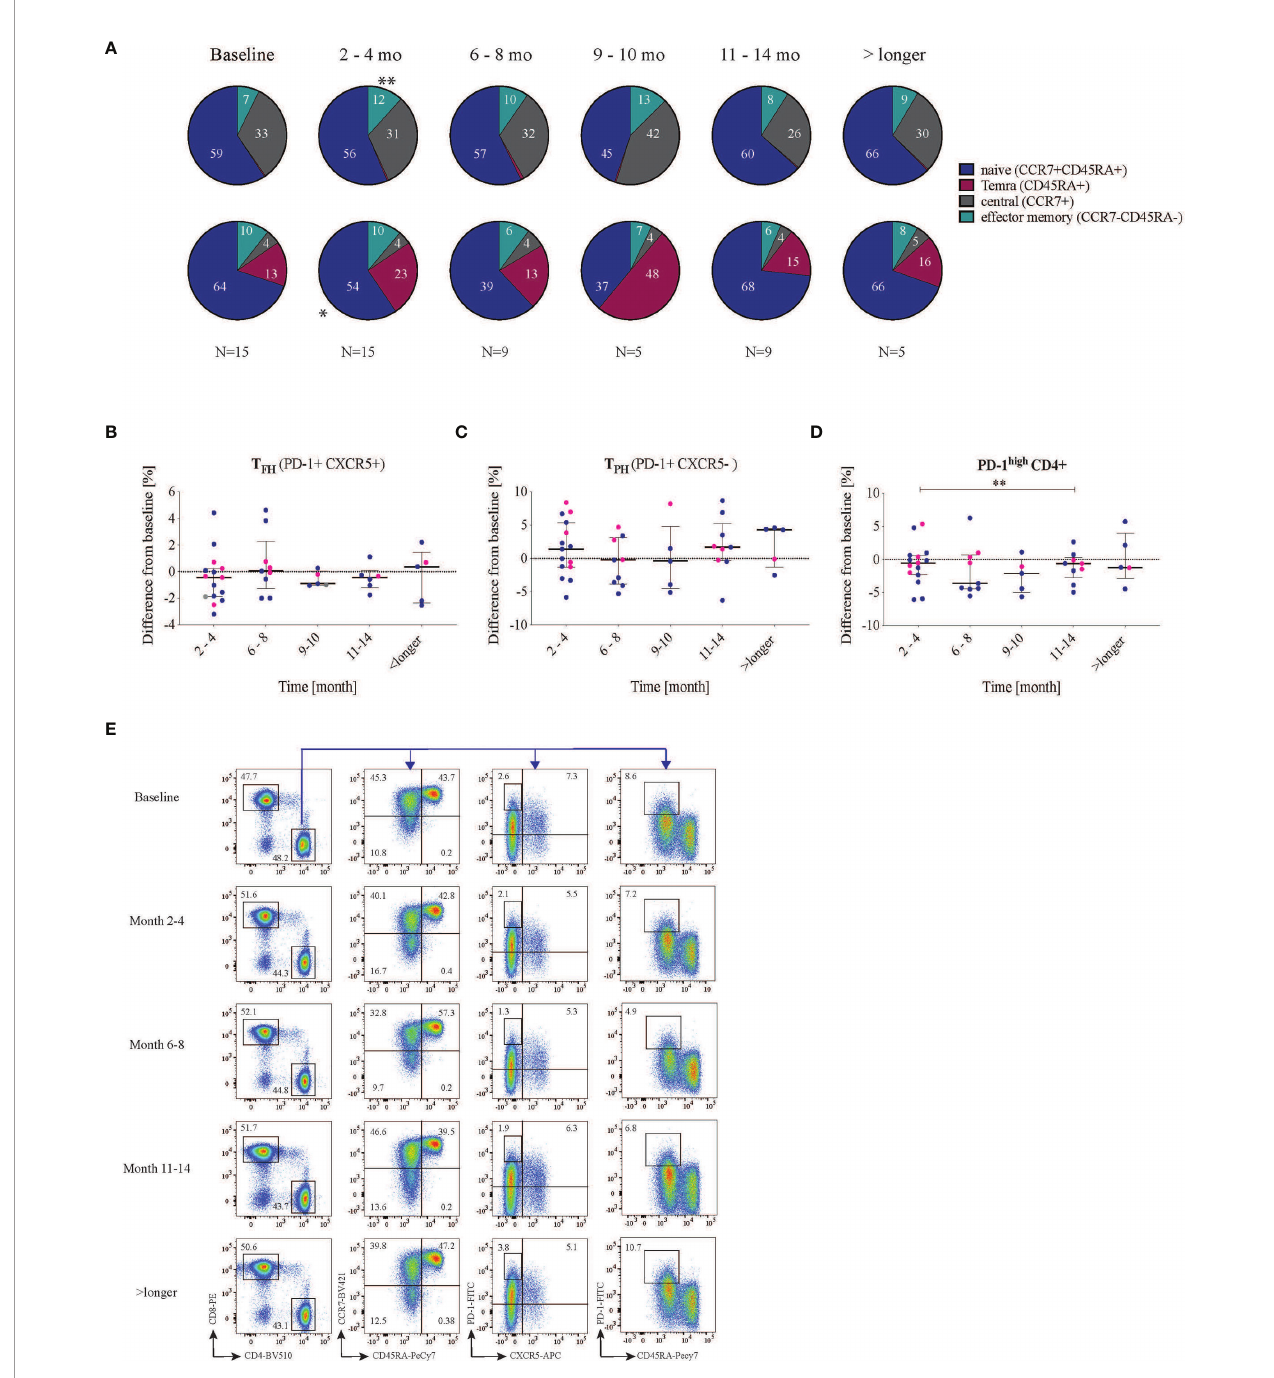
FIGURE 4 | Effect on T cell subsets after RTX treatment. Cells were fi rst gated for living CD3 and then divided into CD4 and CD8 cells. (A) CCR7 and CD45RA were used to subdivide the T cell subsets into naïve (CCR7+ CD45RA+), central memory (CCR7+ CD45RA-) and effector memory (CCR7- CD45RA-) as well as T EMRA (CCR7-CD45RA+) of both CD4 and CD8 cells. (B – D) Shows the difference in frequency from baseline (- values indicate reduction while + values indicate increase from baseline) (B) T follicular helper cells (PD-1+CXCR5+) did not change signi fi cantly in frequency. (C) PD-1+ CXCR5- T cells divide into two groups, one with reduced PD-1 frequency and one with increased PD-1 frequency. (D) PD-1 high CD4+ cells decrease after 2-4 months and signi fi cant reduction can be seen between the months 2-4 and 11-14. Lupus nephritis patients are displayed in blue while non-lupus nephritis patients are shown with pink dots. (E) representative dot plot of the gating strategy in one patient at different time points. * <0.05,